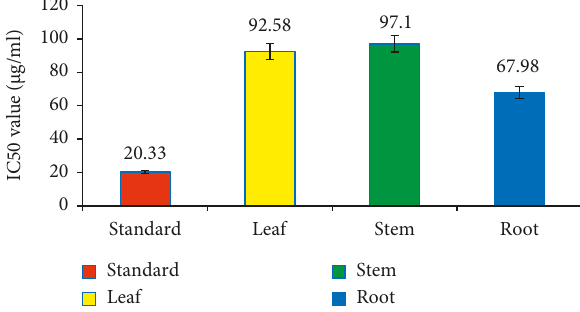
Figure 3: Antioxidant activity of C. lanatum with IC